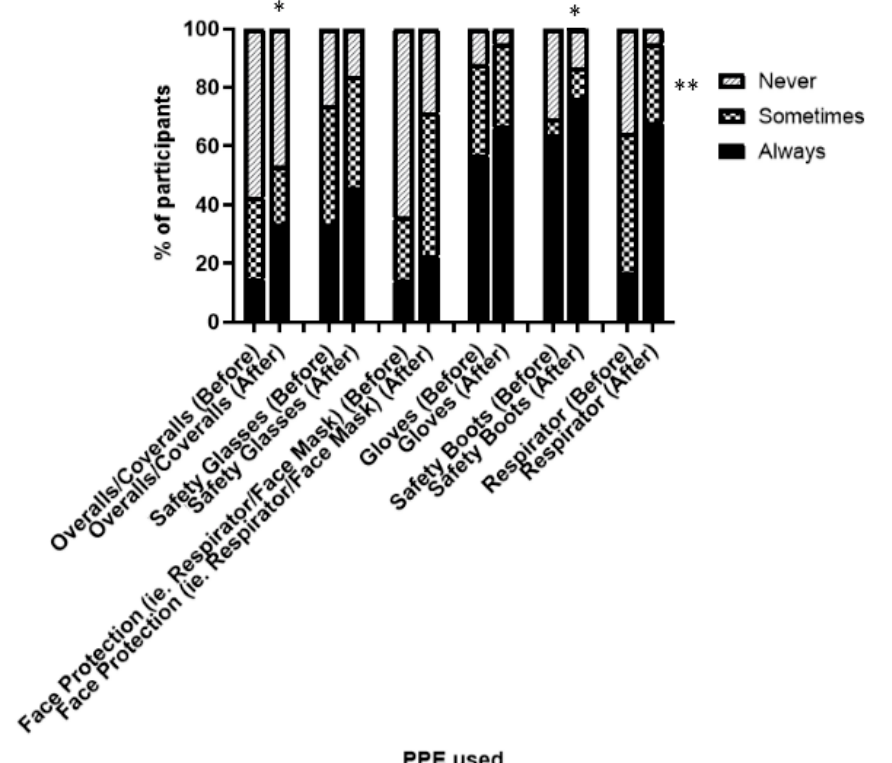
Figure 3. Percentage of participants using PPE pre- and post-PCAP. N = 42. * Significant at p < 0.05, ** Significant at p < 0.01 using Wilcoxon signed-rank test.